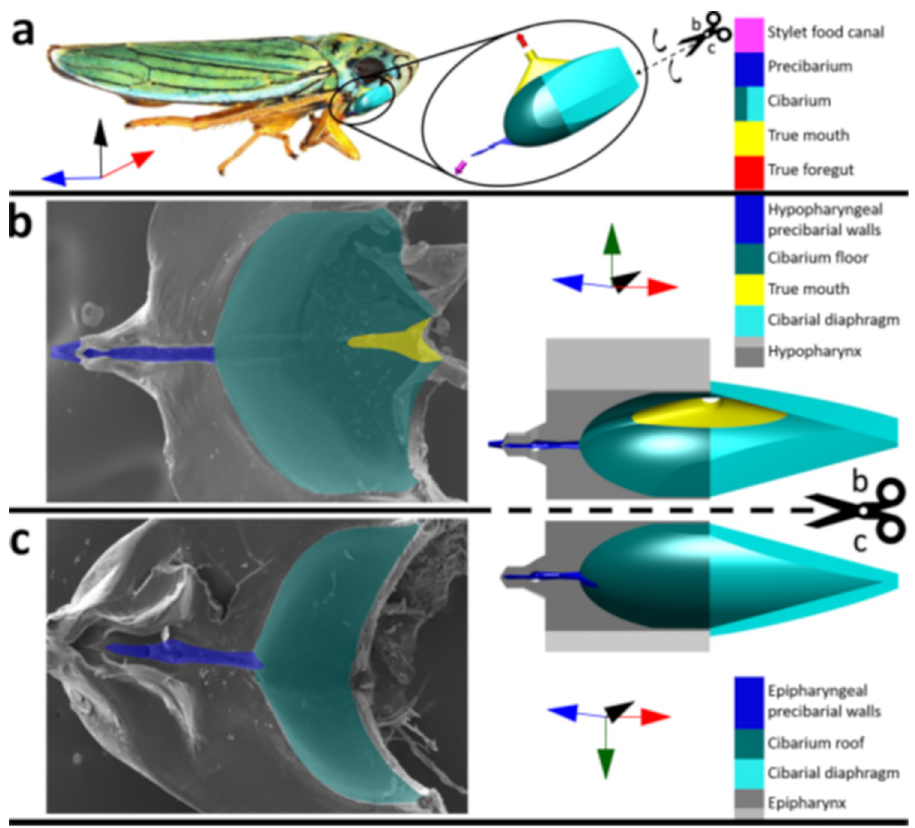
Fig 1. Functional foregut (precibarium and cibarium) of the blue-green sharpshooter, with segments of the 3D model labeled with broad terminology. a) Approximate location/orientation of the functional foregut inside the insect. The 3D model shows an external view of the walls of the precibarium, cibarium, and true mouth, as if the rest of the epipharynx, hypopharynx, and cibarial diaphragm did not exist (convex). b) Hypopharynx electron micrograph (left) and 3D model segment (right, concave, internal) for comparison. The electron micrograph was adapted from a previous publication. c) Epipharynx electron micrograph (left) and 3D model segment (right, concave, internal) for comparison. The coordinate axes indicate anterior ! posterior, distal ! proximal (for the trough), ventral ! dorsal, and left ! right. The relationship between the functional foregut and coordinate axes is different for different sharpshooter species. The scissors and dotted lines indicate where the 3D model in subfigure a would be split to obtain the 3D model segments in subfigures b and c. The associated black curved arrows in subfigure a indicate that the two halves of the split 3D model segment would need to be hinged outward to obtain the views in subfigures b and c. The gray 3D parts of subfigures b and c are semi-abstract representations of the epipharynx and hypopharynx that serve for comparison with their corresponding electron microscope images. (Previously published figure from White, et al [20] is reprinted here under the Creative Commons Attribution 4.0 International License).